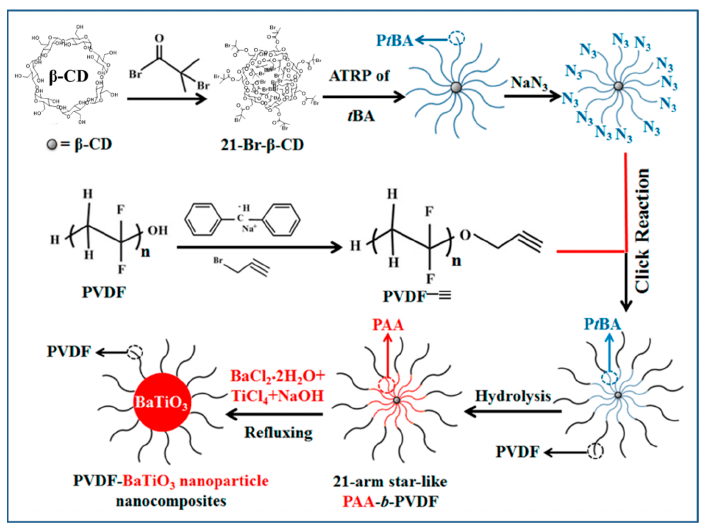
Figure 22. Synthesis of amphiphilic 21-arm, star-like PAA- b -PVDF diblock copolymer and PVDF@BaTiO 3 nanoparticles. Reproduced with permission from Ref